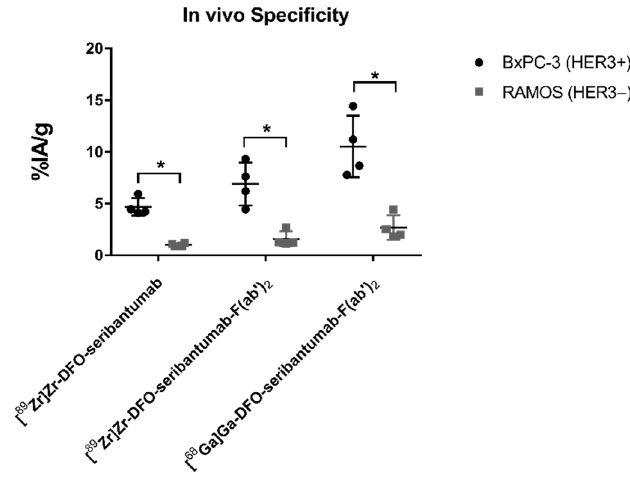
Figure 3. In vivo specificity of [ 89 Zr]Zr-DFO-seribantumab, [ 89 Zr]Zr-DFO-seribantumab-F(ab’) 2 , and [ 68 Ga]Ga-DFO-seribantumab-F(ab’) 2 . Groups of four mice ( n = 4) bearing either HER3-expressing BxPC-3 xenografts or HER3-negative RAMOS xenografts were injected with 27 µg of 68 Ga/ 89 Zr-labeled DFO-seribantumab-F(ab’) or 35 µg [ 89 Zr]Zr-DFO-seribantumab and sacrificed 3 h and 96 h pi, respectively. * Statistically significant ( p < 0.05) difference in tumor uptake.